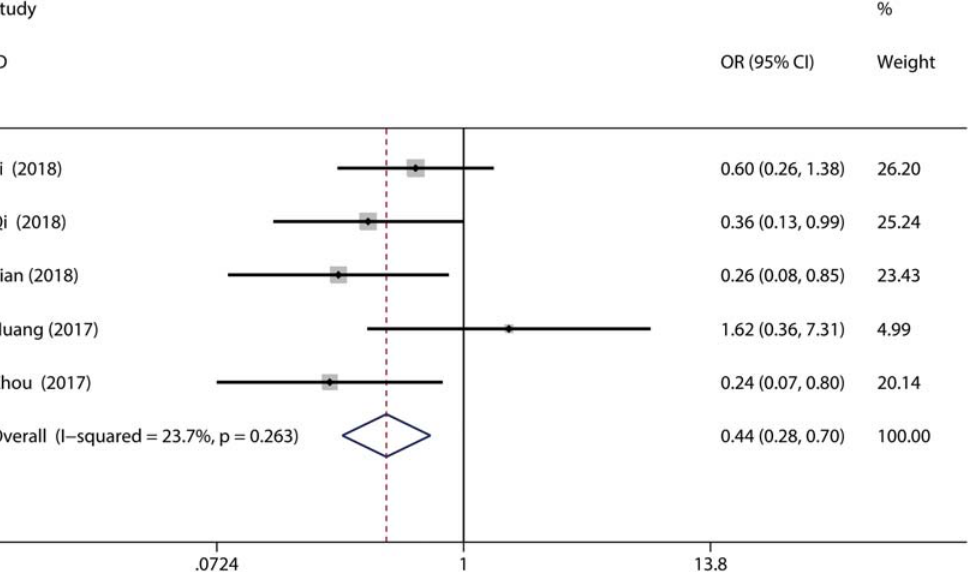
Figure 3: Forest plot for the association between SIRT6 expression and TNM stage in gastrointestinal cancers. Solid diamonds: the OR of each study; squares: weight of each study; horizontal line: the 95% CI of each study; dotted line: the pooled odd ratio; and un fi lled diamond: the pooled results for all